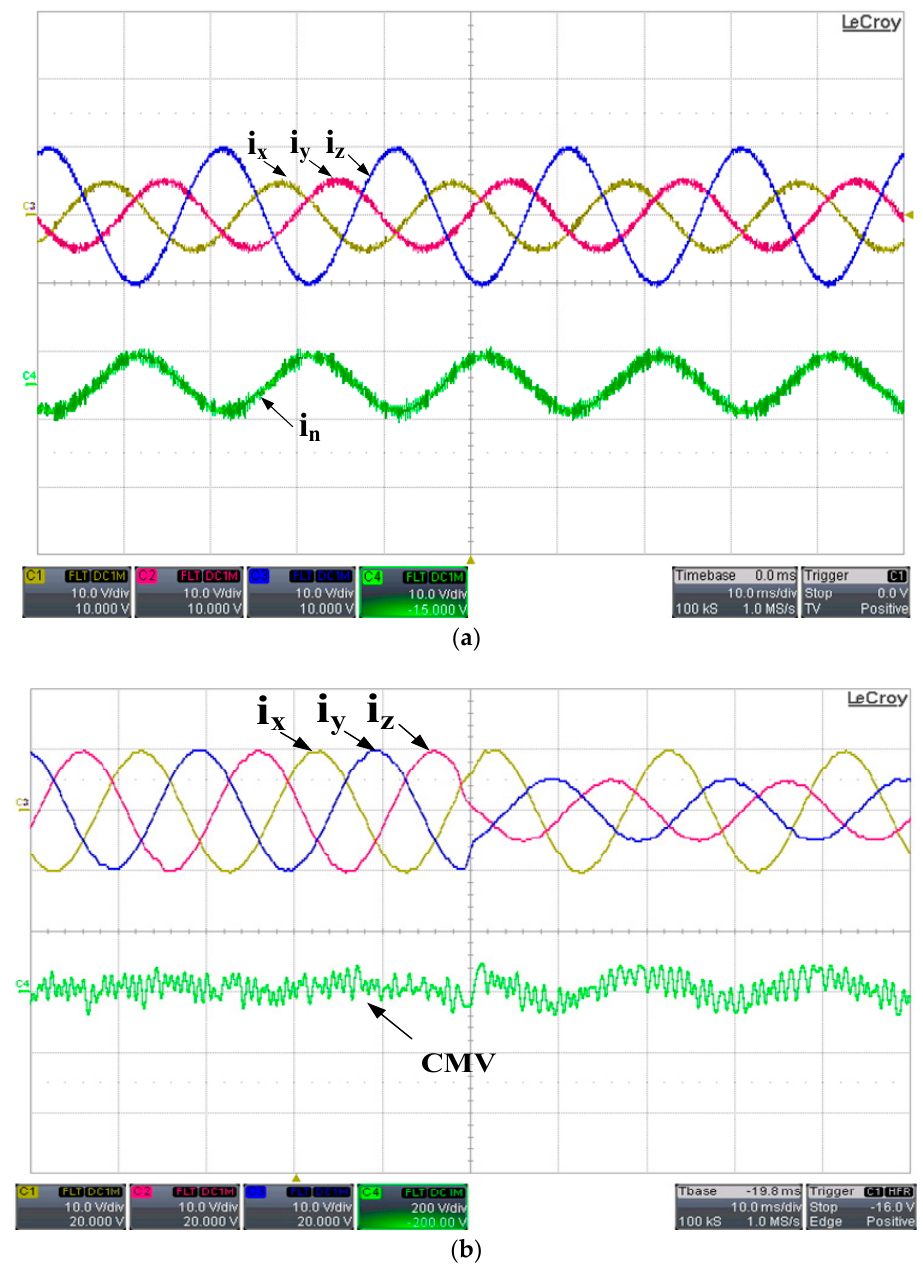
Figure 9. ( a ) Unbalanced references in phase - y and - z from 10 A to 5A with balanced resistive loads and filters, and ( b ) Step change in phase - y and - z references from 10 A to 5A with the proposed NSV-MPC technique.